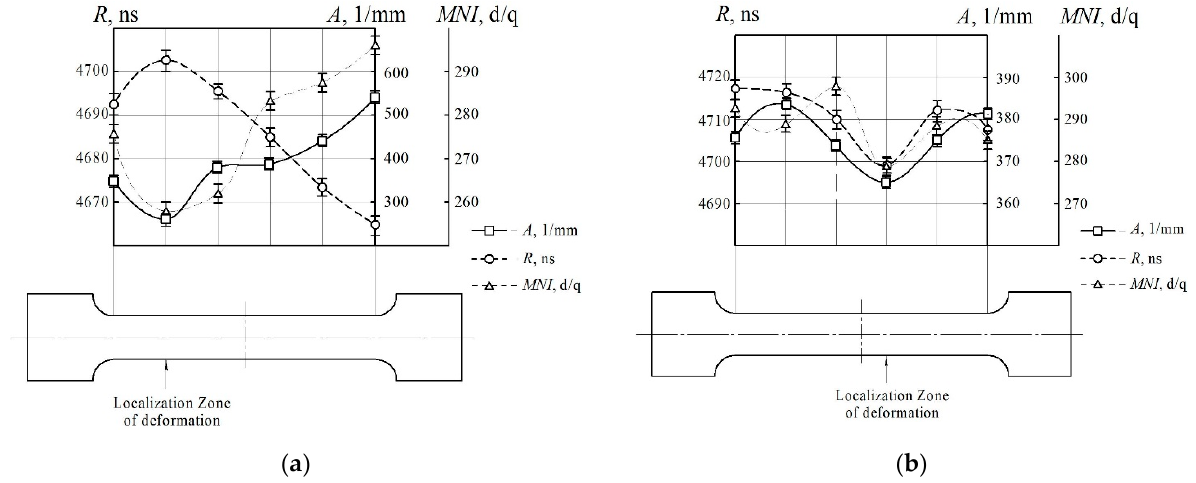
Figure 14. Change in acoustic and magnetic characteristics along the surface of specimens of low-carbon steel: ( a )—initial state; ( b )—after operation without destruction.